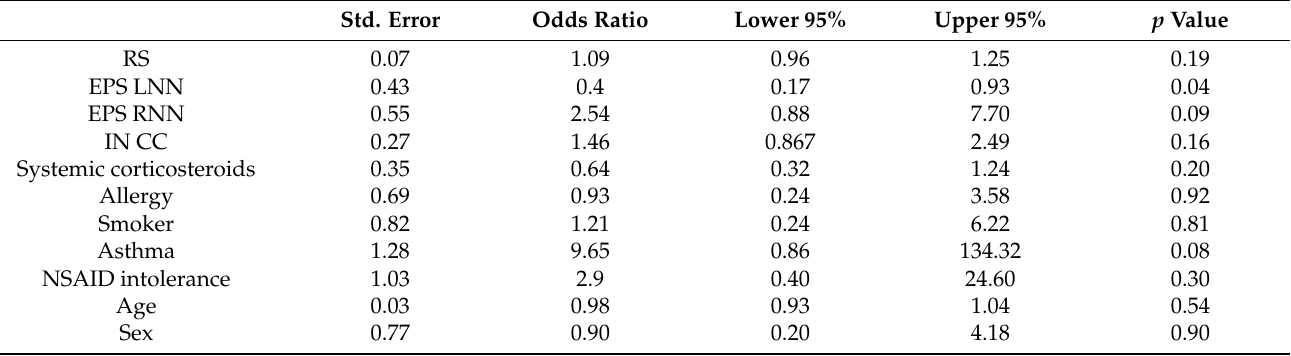
Table 2. Association between QoL measured by SNOT-22 and clinical parameters. RS: radiologic score right nasal nostril, IN CC: intranasal corticosteroids, NSAID: intolerance non-steroidal anti- inflammatory drug